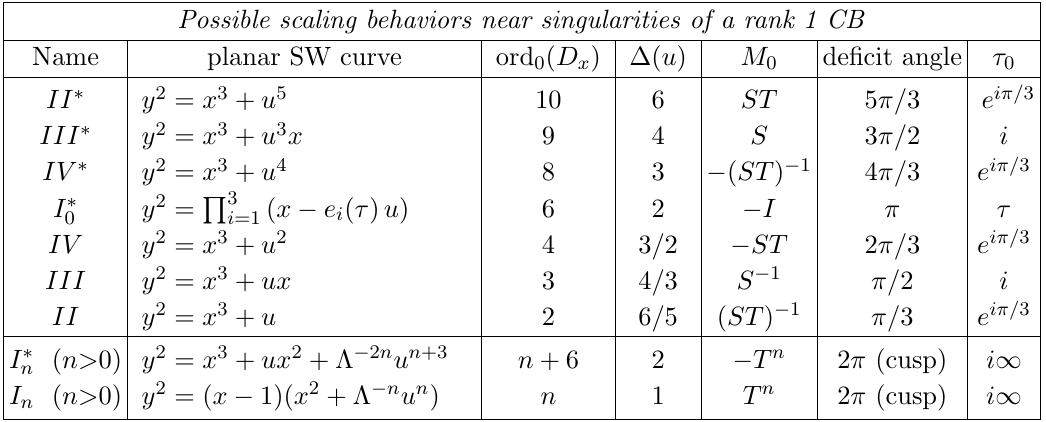
Table 2 . Scaling forms of rank 1 planar special K(cid:127)ahler singularities, labeled by their Kodaira type (column 1), a representative family of elliptic curves with singularity at u = 0 (column 2), order of vanishing of the discriminant of the curve at u = 0 (column 3), mass dimension of u (column 4), a representative of the SL(2 ; Z ) conjugacy class of the monodromy around u = 0 (column 5), the de(cid:12)cit angle of the associated conical geometry (column 6), and the value of the low energy u(1) coupling at the singularity (column 7). The (cid:12)rst seven rows are scale invariant. The last two rows give in(cid:12)nite series of singularities which have a further dimensionful parameter (cid:3) so are not scale invariant; they can be interpreted as IR free theories since (cid:28) 0 = i 1